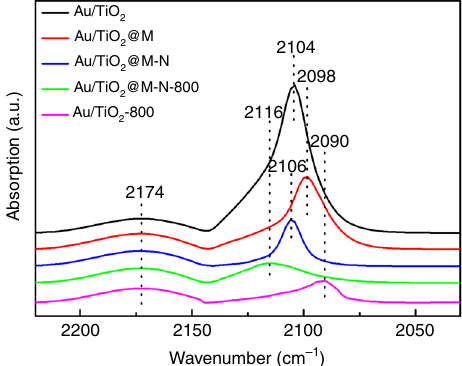
Fig. 3 DRIFTS analysis. In situ DRIFT spectra of CO adsorption on Au/ TiO 2 , Au/TiO 2 @M, Au/TiO 2 @M-N, Au/TiO 2 @M-N-800, and Au/TiO 2 -